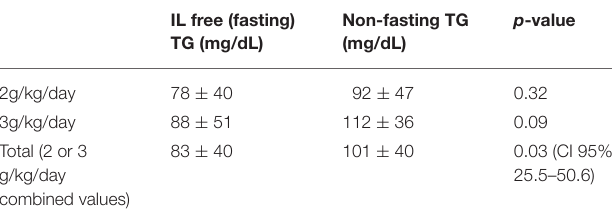
TABLE 2 | Fasting and non-fasting TG levels at 2g/kg/day, 3g/kg/day IL infusions and when combined at either infusion rate. IL free (fasting) Non-fasting TG TG (mg/dL)